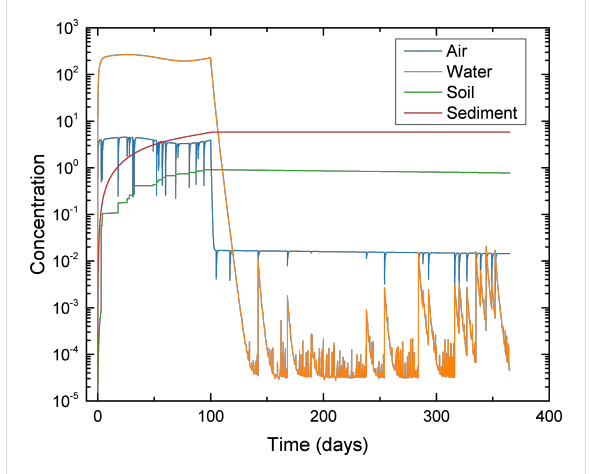
Figure 9: Effect of release scenario on temporal dynamics of TiO 2 media concentrations in Los Angeles. TiO 2 release rates to air and water were obtained from LearNano (Supporting Information File 1, Table S5). The ENM release rates (into air and water) followed a sinu- soidal function for the first 100 days (cycle period of 100 days, ampli- tude of 13.7 and 53.1 kg/day, for releases to air and water, respective- ly), after which the source releases are terminated. Regional geographical parameters are reported in Supporting Information File